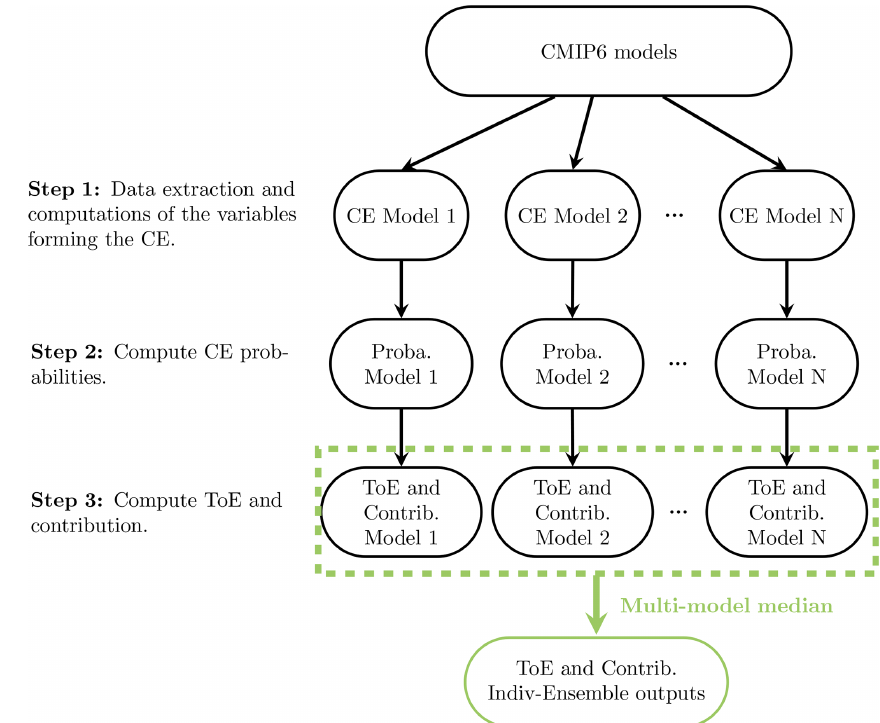
Figure 3. Flowchart for the computations of time of emergence and contributions for the Indiv-Ensemble